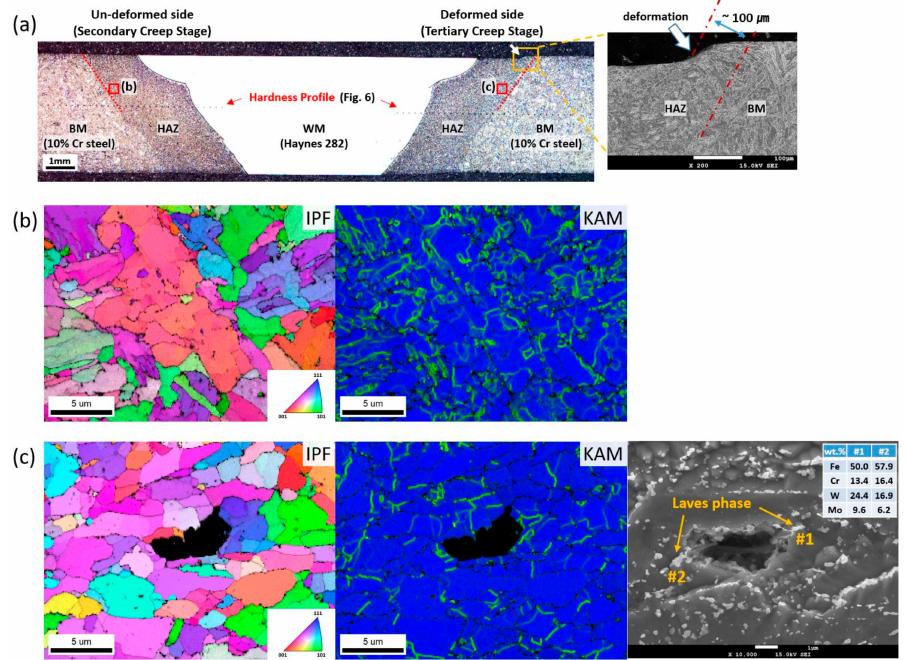
Figure 5. Creep interruption results conducted at 630 ◦ C/150 MPa: ( a ) macro image following creep interruption test; and EBSD (IPF and KAM) analysis for ( b ) un-deformed ICHAZ and ( c ) deformed ICHAZ (including EDS analysis of the precipitates marked with